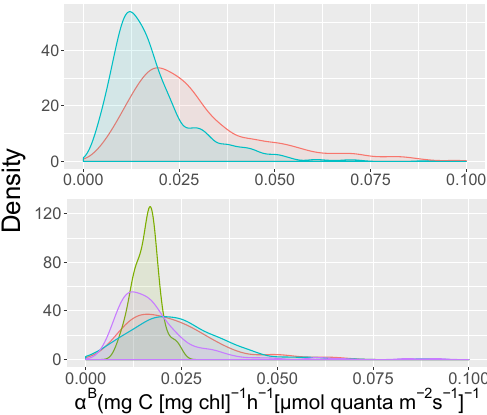
Figure 3. (a) Density plots of the initial slope ( α B ) obtained us- ing a tungsten halogen lamp (cyan) and corrected values using the shape of the phytoplankton absorption spectrum (red) as described in Kyewalyanga et al., 1997. (b) Density plots of data collected in the North Atlantic using different lamp types (red – GTE Sylvania PAR 150; green – combination of GTE Sylvania PAR 150 (irradi- ances < 200W) and New Haline OHS tungsten halogen (irradiances 200–1000W); cyan – New Haline OHS 2000 tungsten halogen; pur- ple – Gilway Technical Lamp L 7391 tungsten halogen). Both plots are using data collected within the top 20m of the water